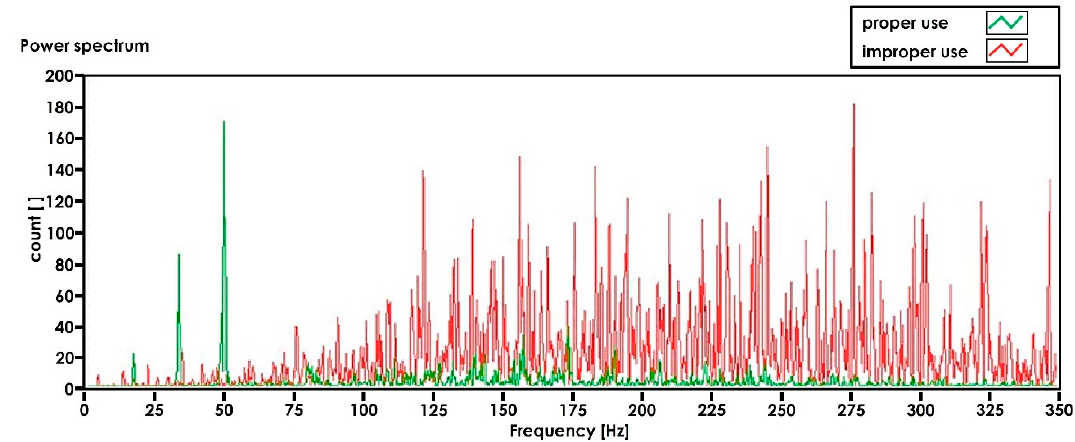
Figure 10. Power spectrum for the recorded acceleration: proper vs. improper use of the hammer. Apart from accelerometers, the testing system was also equipped with classical strain gauges.